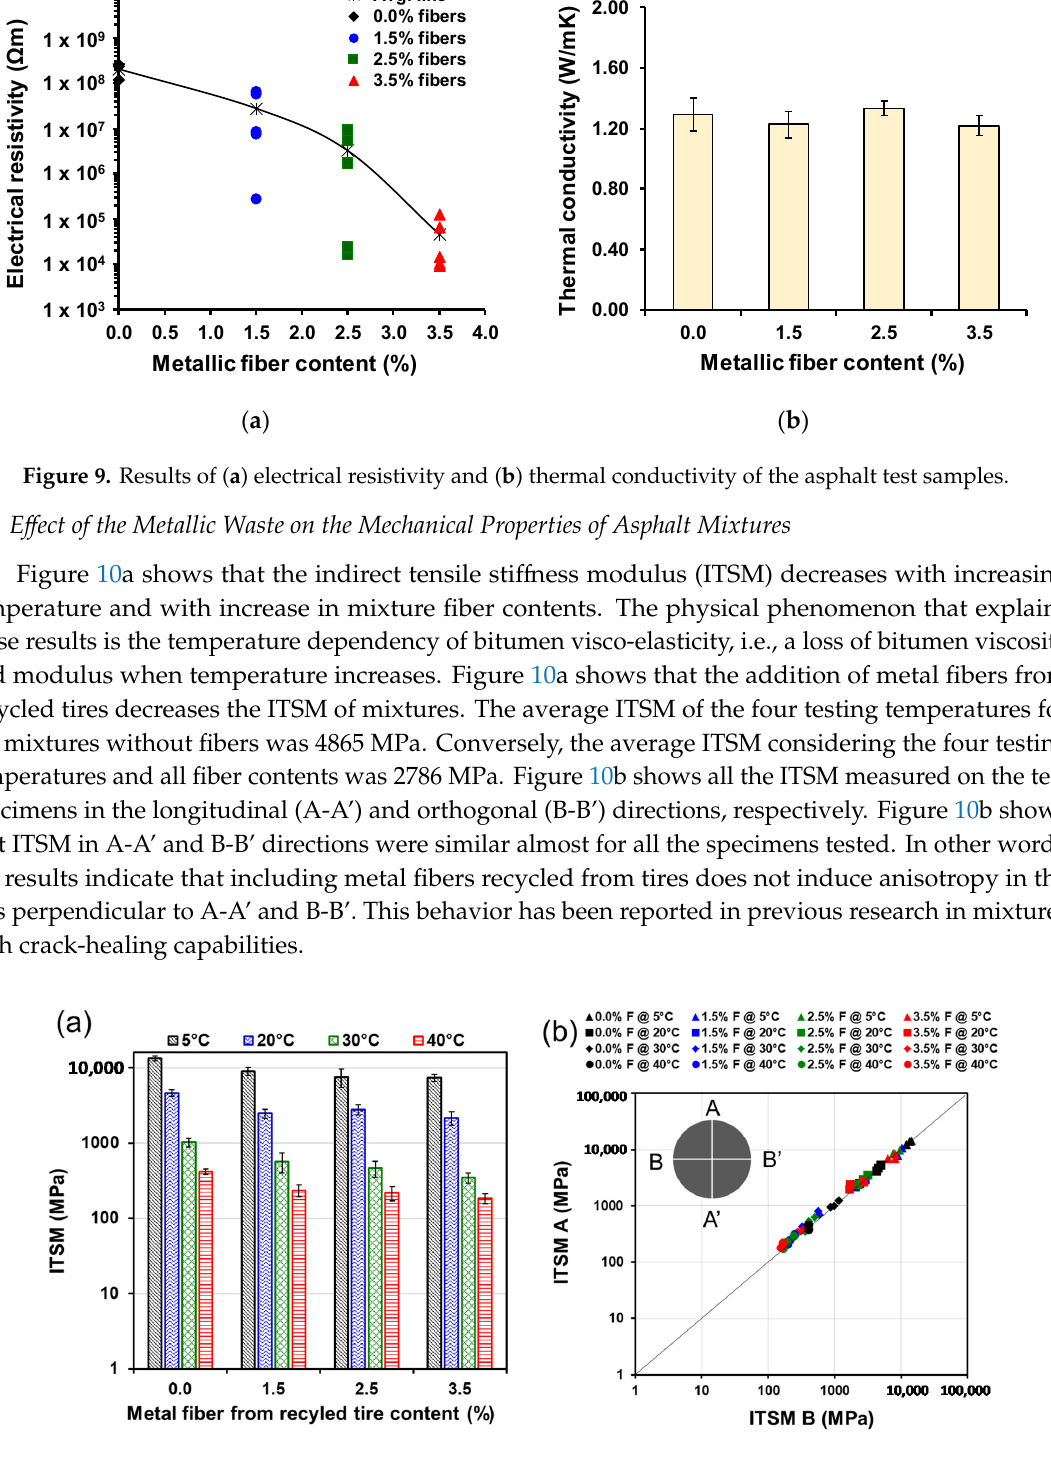
Figure 10. Effect of metal fiber from recycled tires fiber on ( a ) indirect tensile stiffness modulus ( b ) anisotropy.